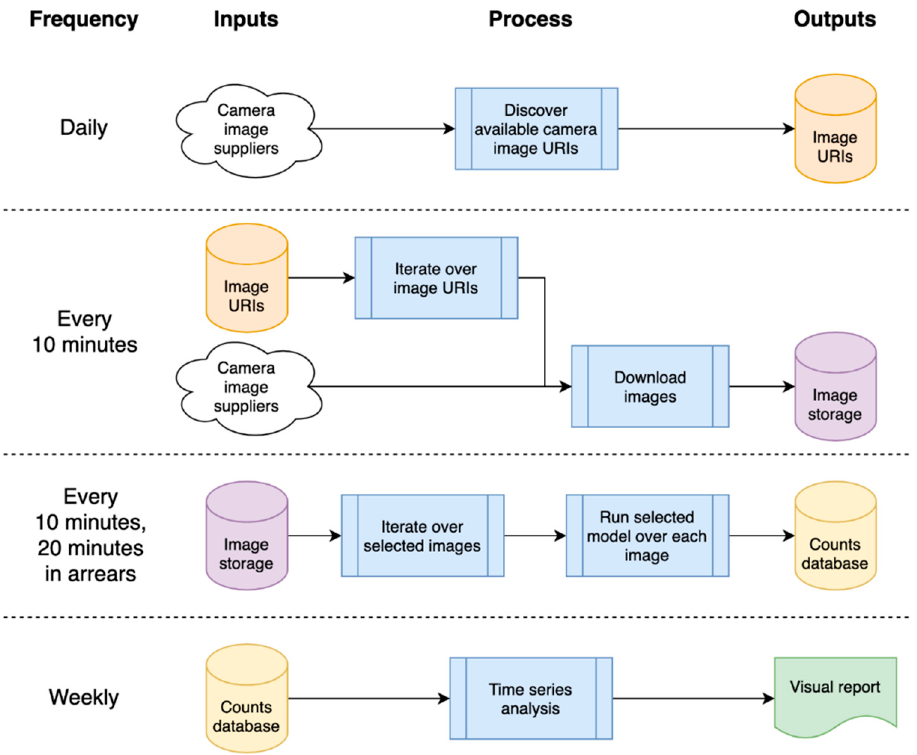
Figure 5. High-level architecture of processing pipeline, showing timings and input/output de-